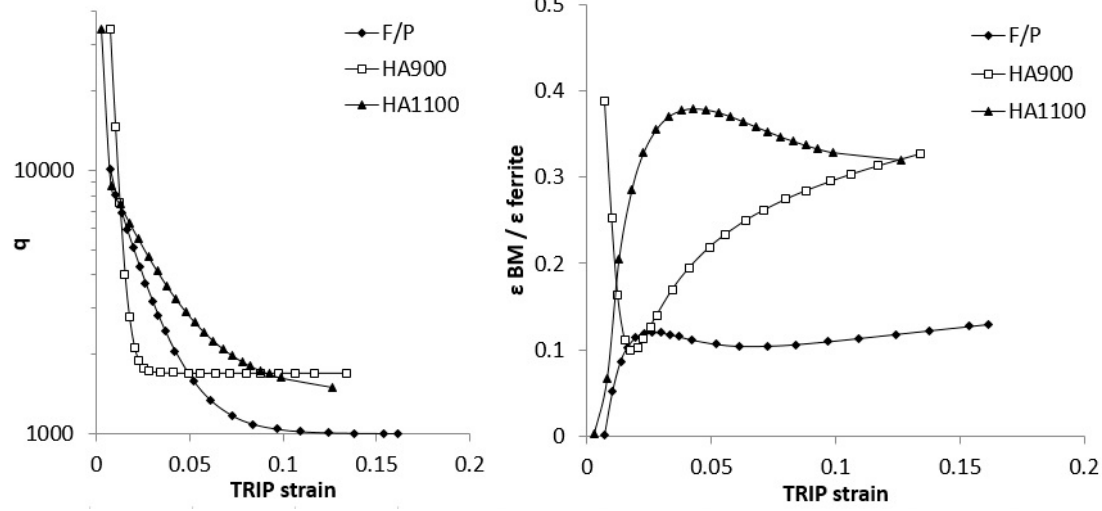
Figure 11. q curves and strain partition for the three steels.